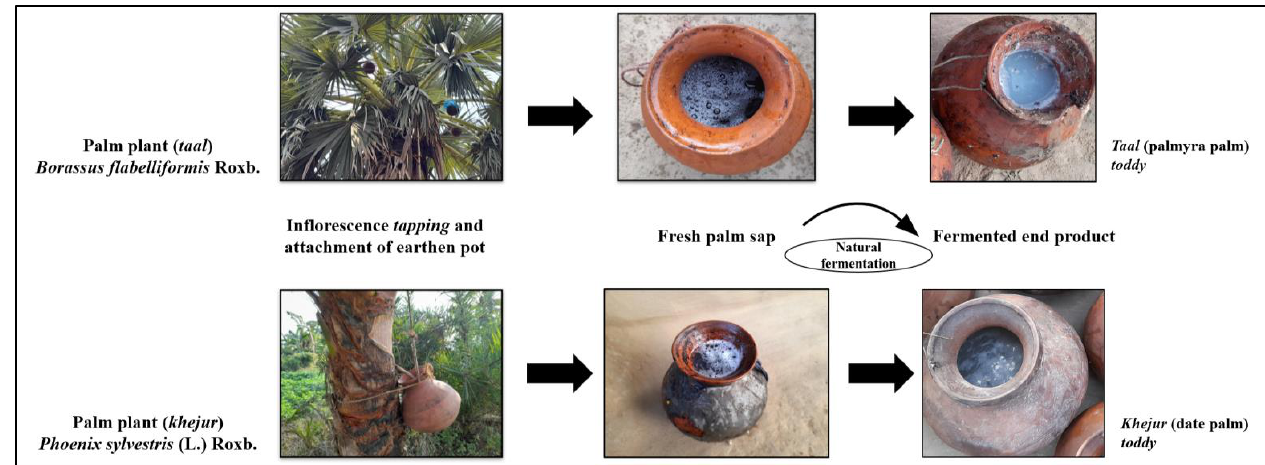
Figure 1. Methods of preparation of Indian palm beverage: ( a ) taal toddy (top) and ( b ) khejur toddy (bottom) .